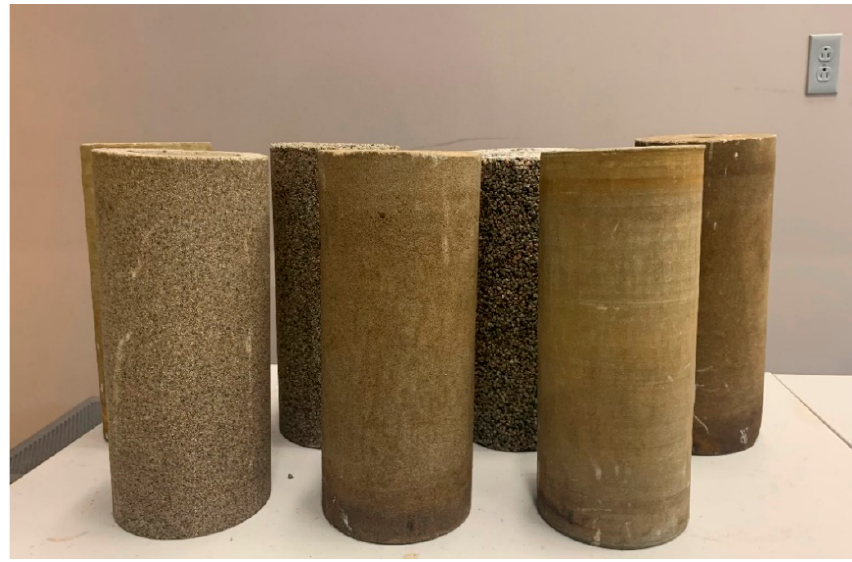
Figure 3. Porous medial samples. Table 1. The porous media properties.